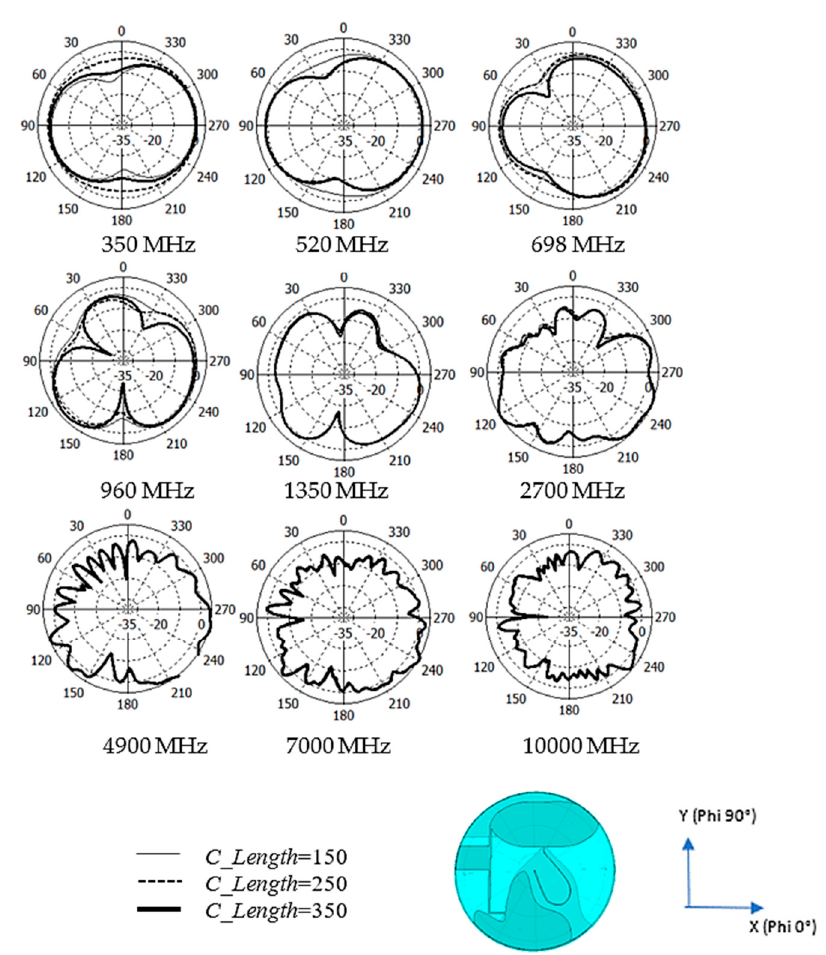
Figure 14. Comparison of simulated radiation pattern proposed dipole antenna at Azimuth Plane (theta 90°/X-Y) from 350 MHz to 10,000 MHz with a variance of cable length, C_Length .